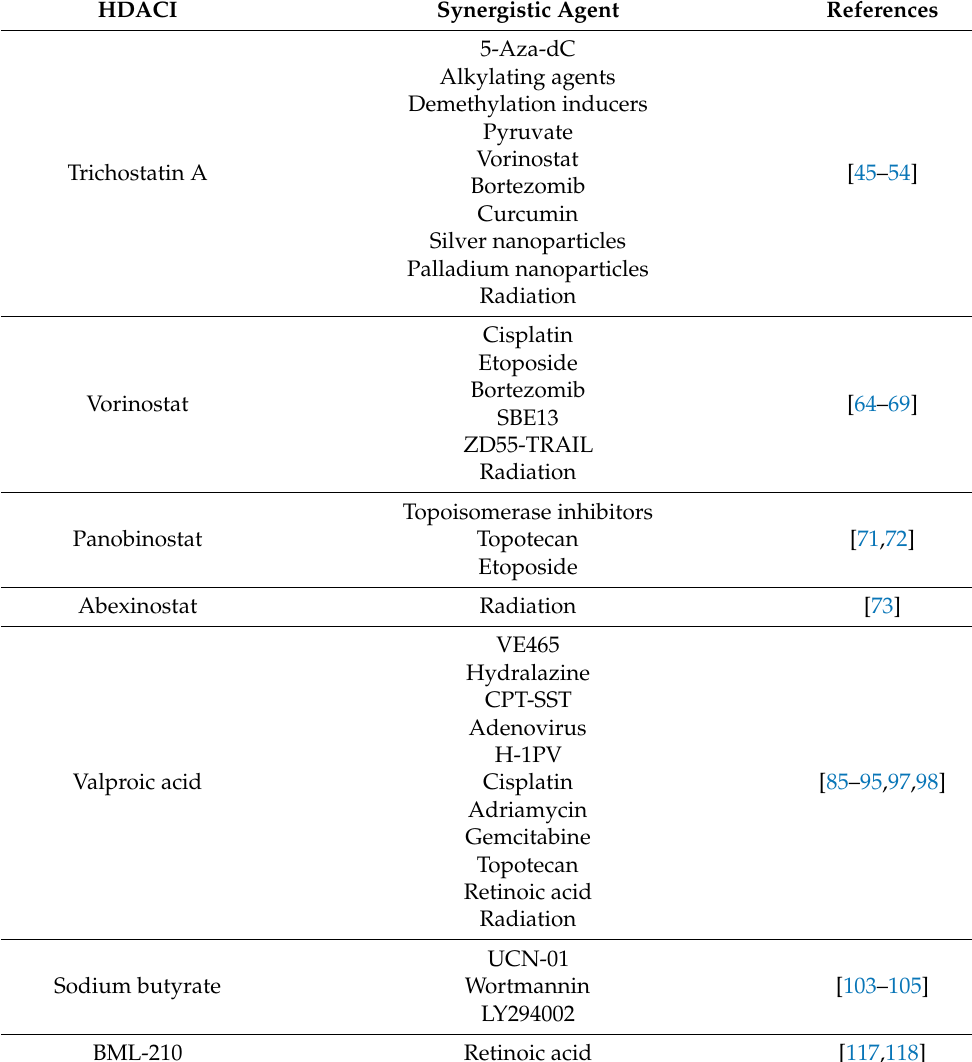
Table 4. Possible combinations of HDACIs with other treatment agents for synergistic cervical cancer